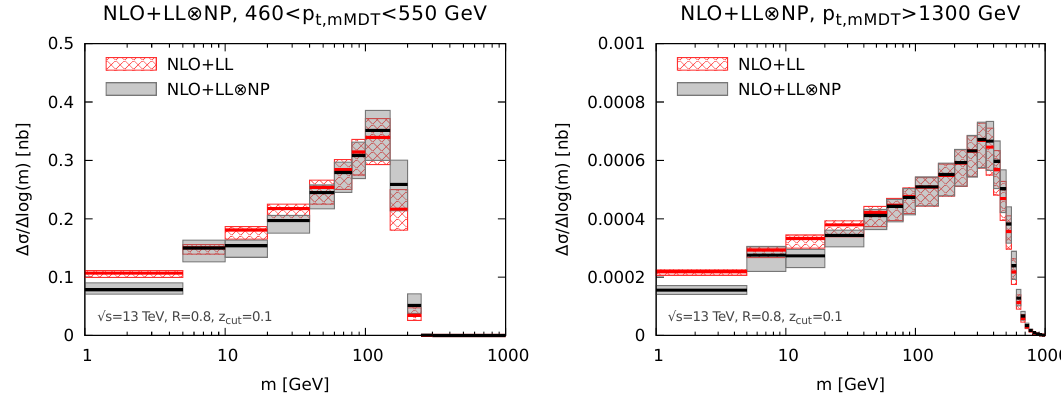
Figure 13 . Final results at NLO+LL, with non-perturbative corrections, for the p t; mMDT selection. ( m . 10 GeV) and at very large masses, close to the end-point region. Nevertheless, there exists a region in mass, which increases in size as p grows, where non-perturbative t; jet